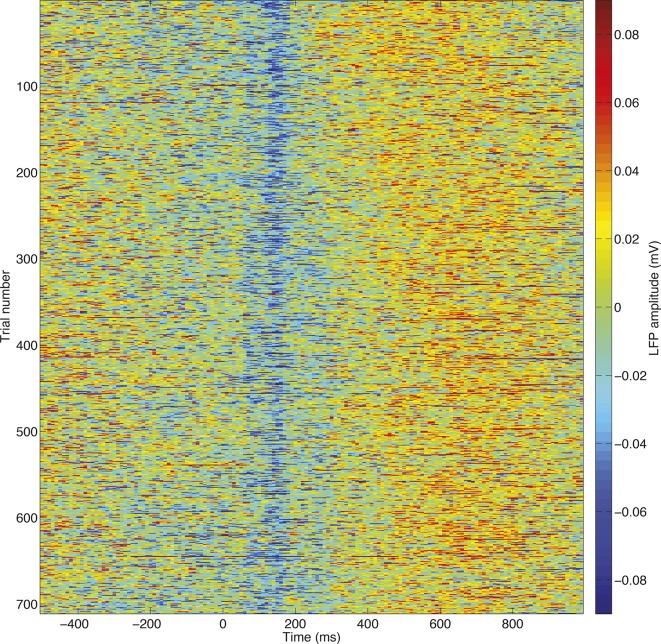
High signal to noise ratio in single-trial LFP responses.All trials, unfiltered, from a single session are stacked for an example electrode. The evoked potentials plotted in (Figure 1—figure supplement 2) and (Figure 2—figure supplement 1) can clearly be seen at the single trial level, allowing single trial dynamics to be readily estimated.